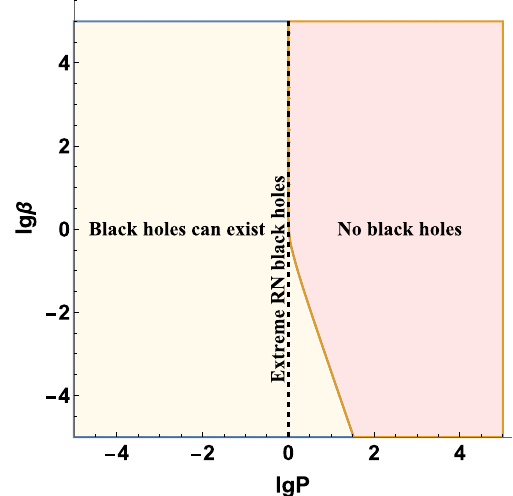
Fig. 1 Region plot in lg β − lg P space for magnetically charged BI BH with fixed M = 1. Black holes can only exist in the light yellow area. The critical value of the magnetic charge P increases with the decrease of β . The black dashed line ( P = 1 ) represents extreme RN BHs. To display a wider plot range, we use logarithmic coordinates